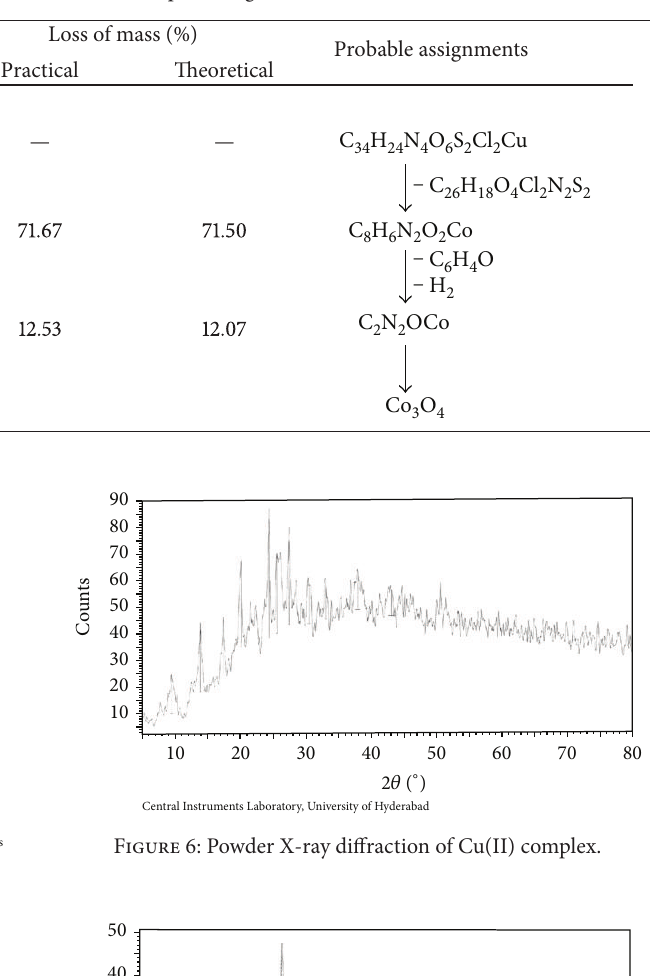
Table 5: Thermal decomposition of Co(II) complex of ligand HL.